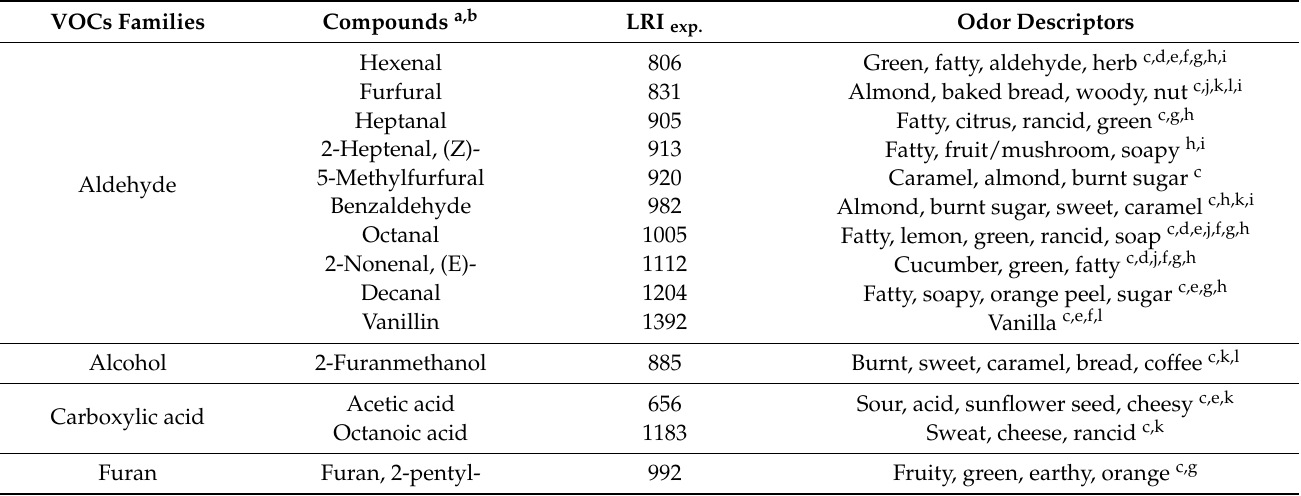
Table 4. Volatile organic compounds coming from flax fibers of NFC shaped for heat press tempera- tures between 200 and 240 ◦ C for different core